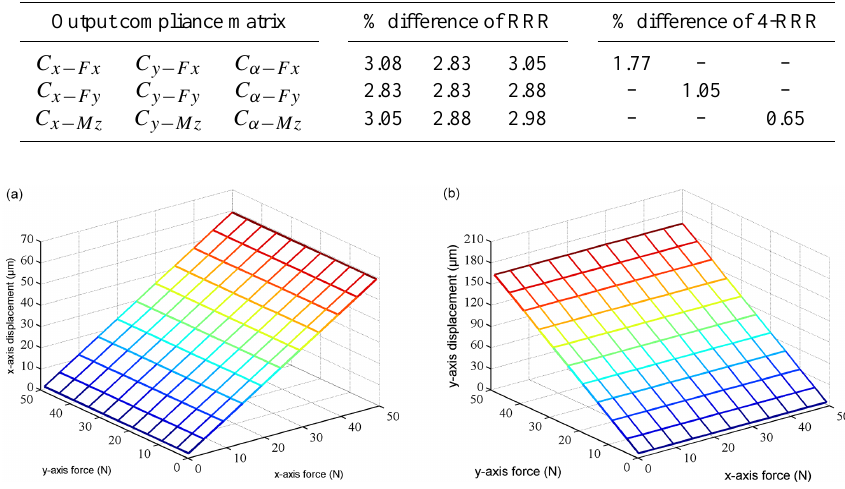
Figure 11. FEA results of force-displacement relationship: (a) displacement of x axis; (b) displacement of y